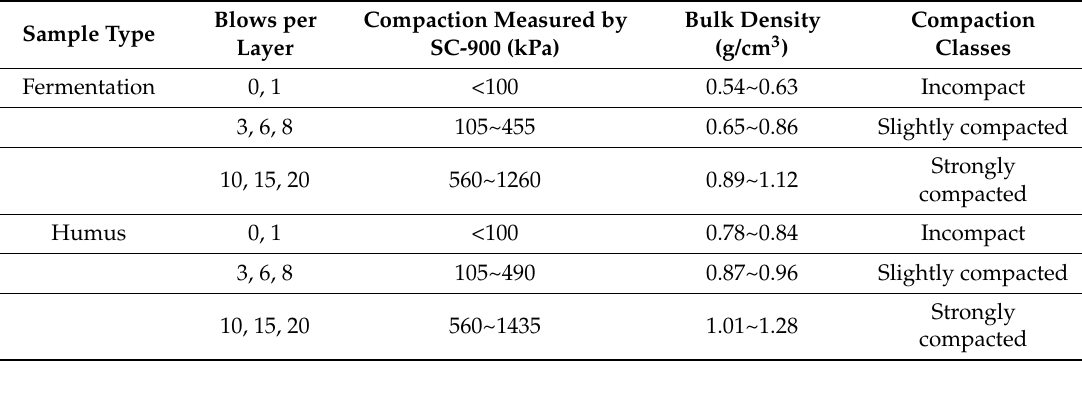
Table 1. Classification of blows per layer in the Proctor compaction test used for the characterization of sample compaction.